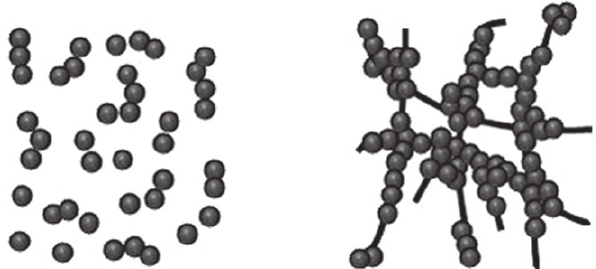
Figure 2 Schematic visualization of the autopolycondensation of silica particles (dark dots) which facilitates 3D gel network forma- tion (left scheme) and localized silicification (right scheme) caused by the presence of fibrillar collagen (black